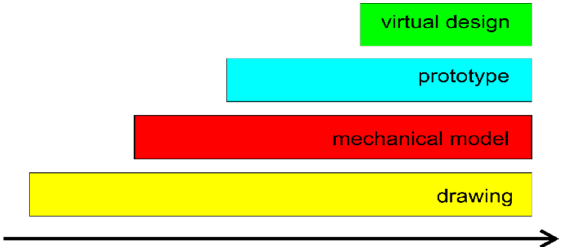
Figure 1. A timeline of conceptual evolution of mechanism models [17].